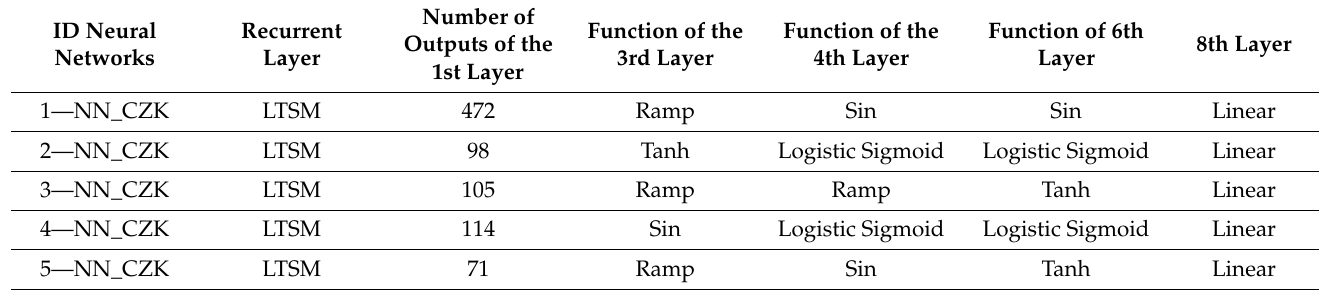
Table 4. Retained neural networks for predicting CZK price.